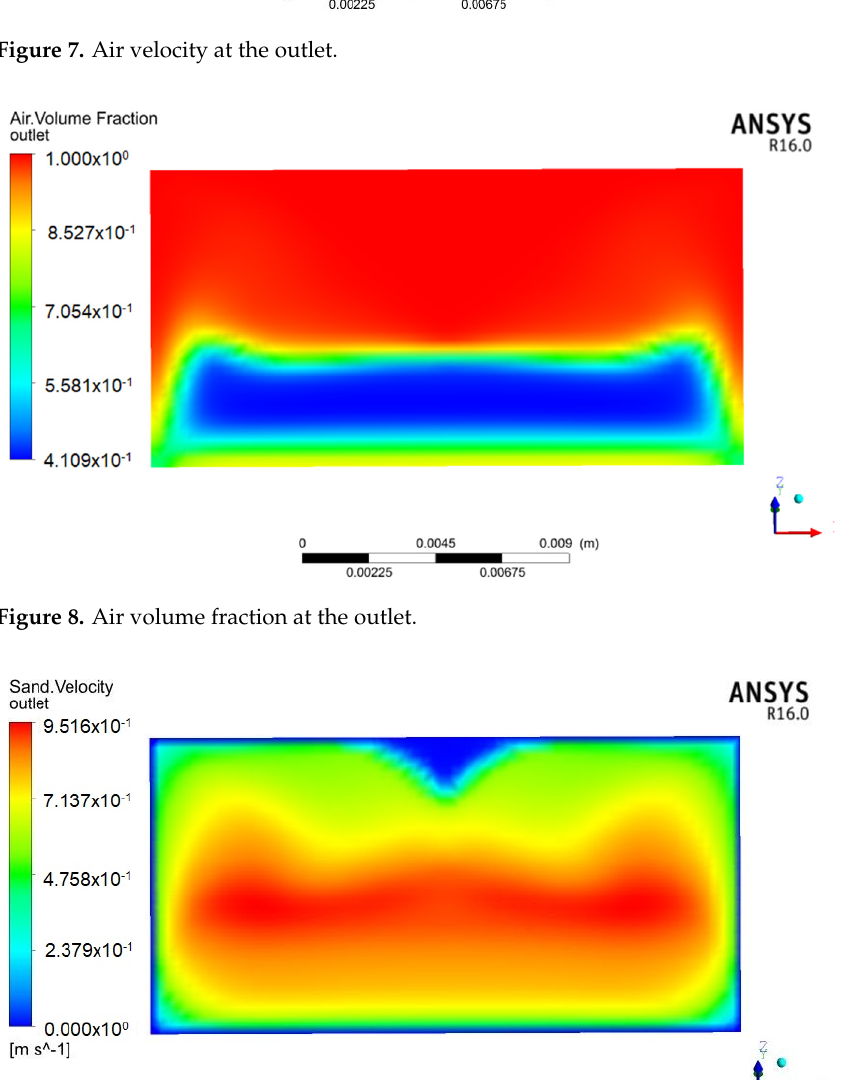
Figure 10. Sand volume fraction at the outlet. Similar to the air velocity profile, the solid particles also exhibit a well-defined reg- ular pattern of the velocity profile, as shown in Figure 9. The region of the air–solid in- teraction offers the maximum velocity of 0.951 m/s. However, the suspended negligible small concentration of the particles shows a comparatively low velocity, as shown in Figure 9. Therefore, their impact on the mass flow rate measurement is ignorable since its concentration is too low. Numerical simulation of pneumatic flow is important to the visualization of solid flow [34]. Choking flow pipes and ducts because of cohesiveness is a big issue in the process industry [35,36]. Simulation results show the effect of gravity on the movement of the particles. However, the concentration of the suspended particles was low compared to the sliding particles at the bottom surface, but the moving air tends to suspend the solid particles. Based upon Figures 6 and 10 from the simulation analysis, we observed that the volume fraction and the velocity of the solid particles do not remain constant along the z-axis. Instead of using a circular channel, a rectangular channel was used to ensure that all the velocity and volume fraction variations are within the upper and lower surface. Additionally, the electrodes of the electric sensors will be attached to the lower and upper surfaces to guarantee that particles must flow between the elec- trodes only [37].